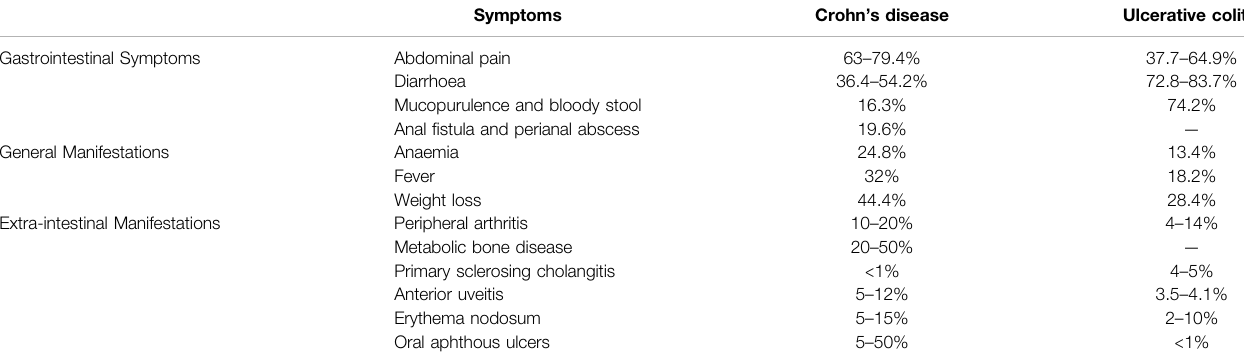
TABLE 1 | The proportion of the clinical symptoms of IBD (Li et al., 2017; Annese, 2019; Rogler et al.,